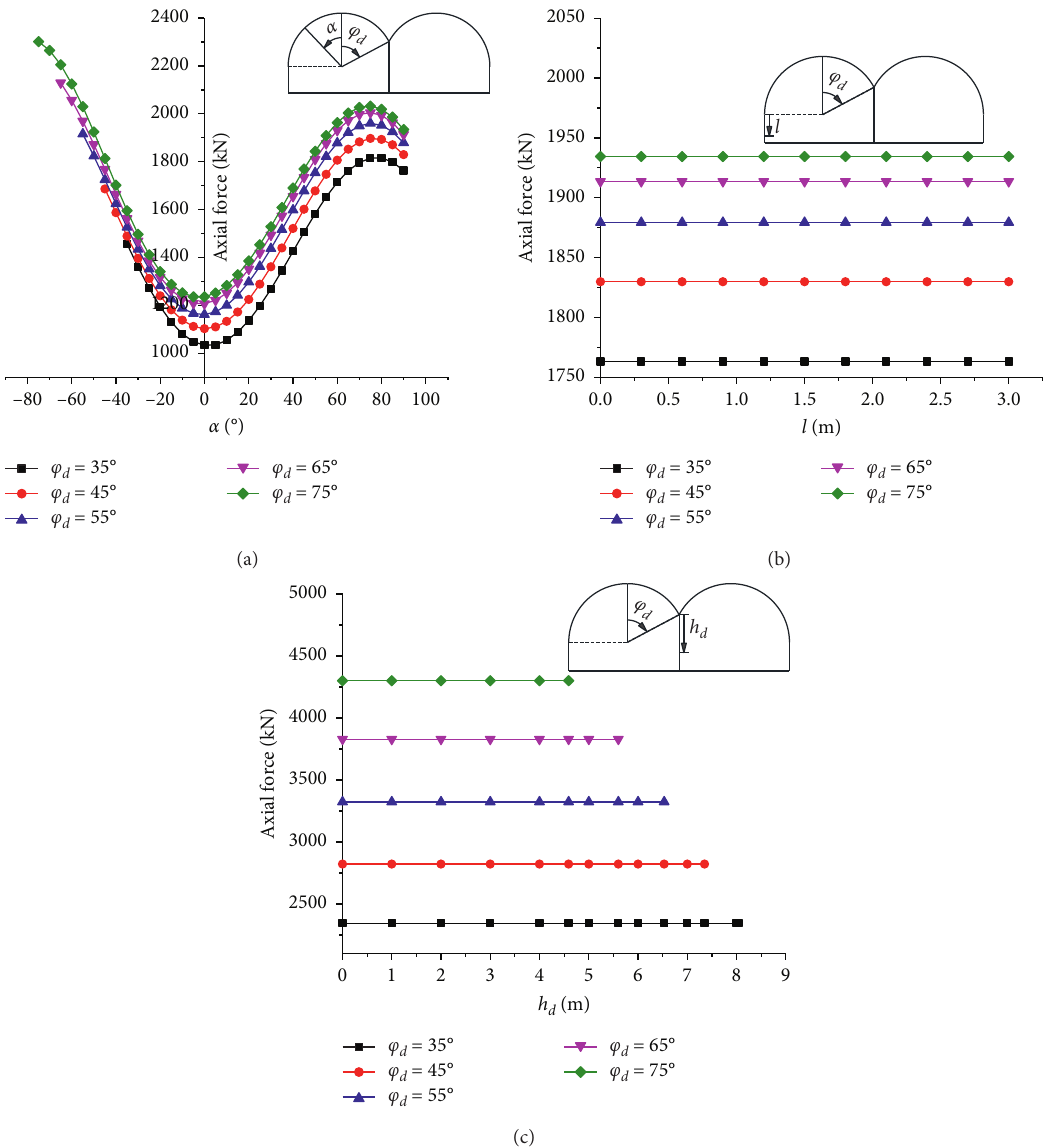
Figure 19: Variations of axial force with φ d : (a) along the arch ring; (b) along the side wall, and (c) along the middle